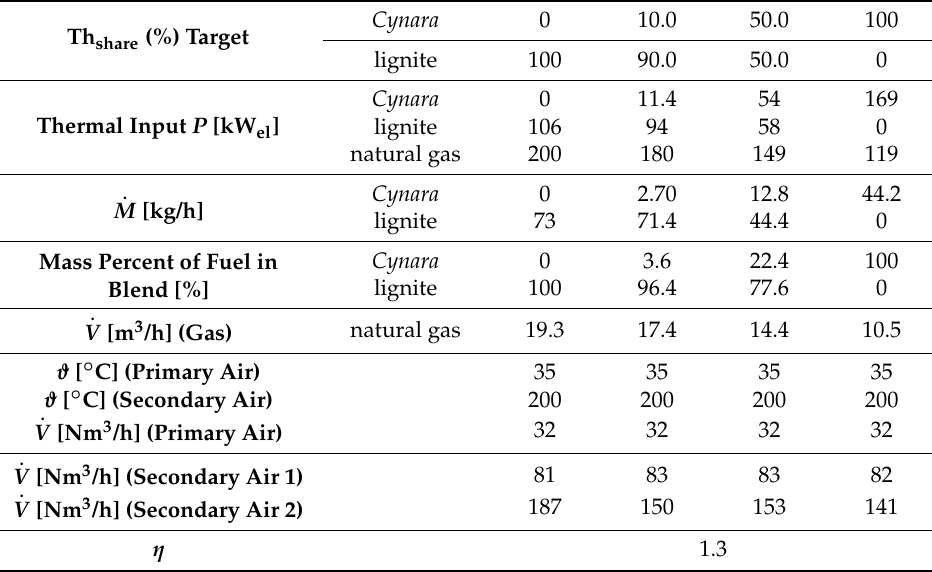
Table 1. Cynara pilot scale tests’